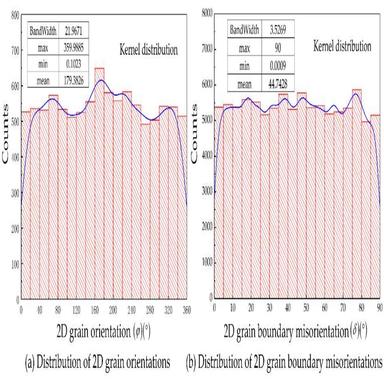
Distributions of 2D grain orientations and grain boundary misorientations.